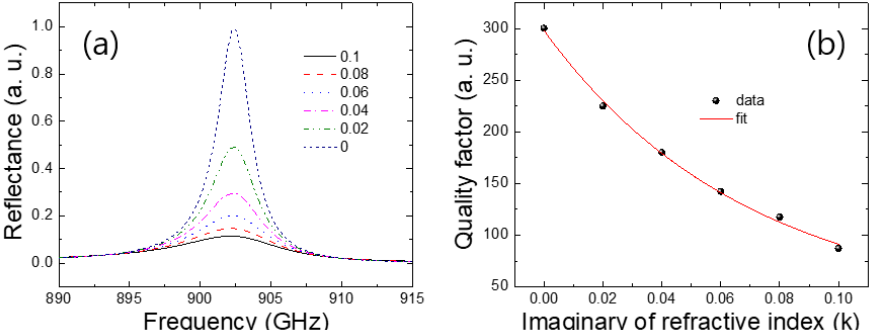
Figure 8. Dependence of the imaginary refractive index on the thickness of the sensing layer: ( a ) THz reflectance and ( b ) the quality factor.